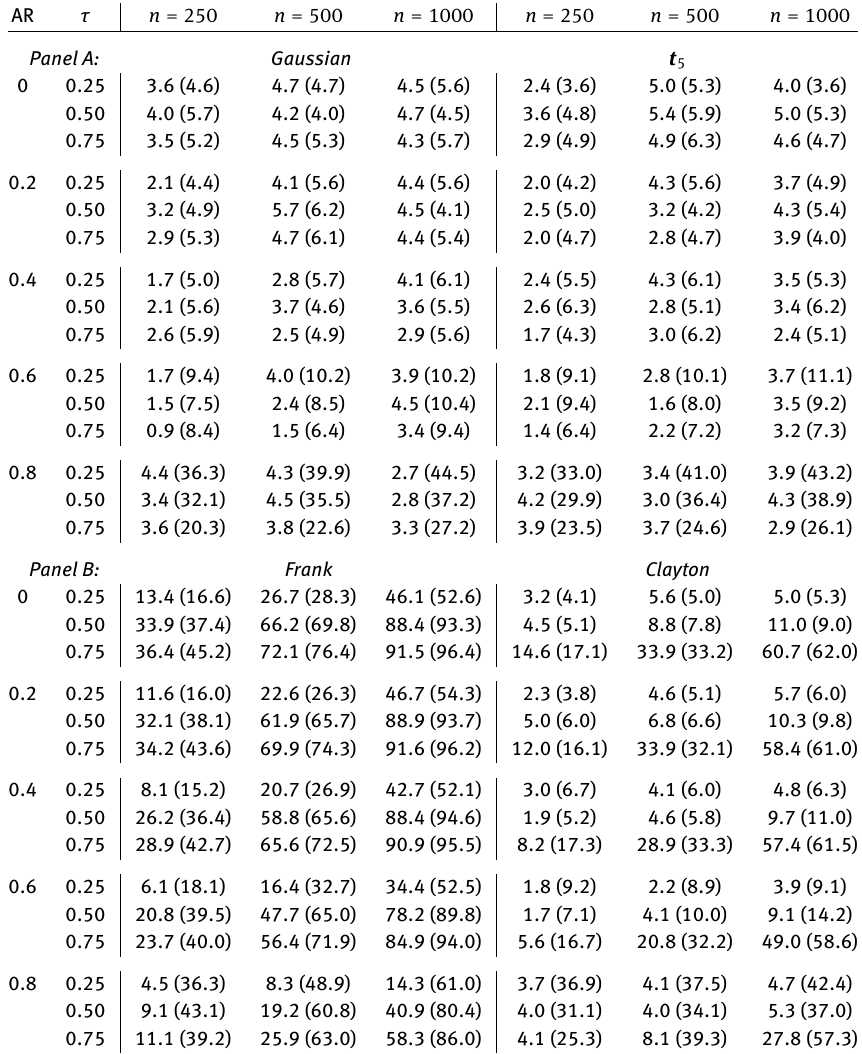
Table 2: Analogue of Table 1 in dimension d = 3